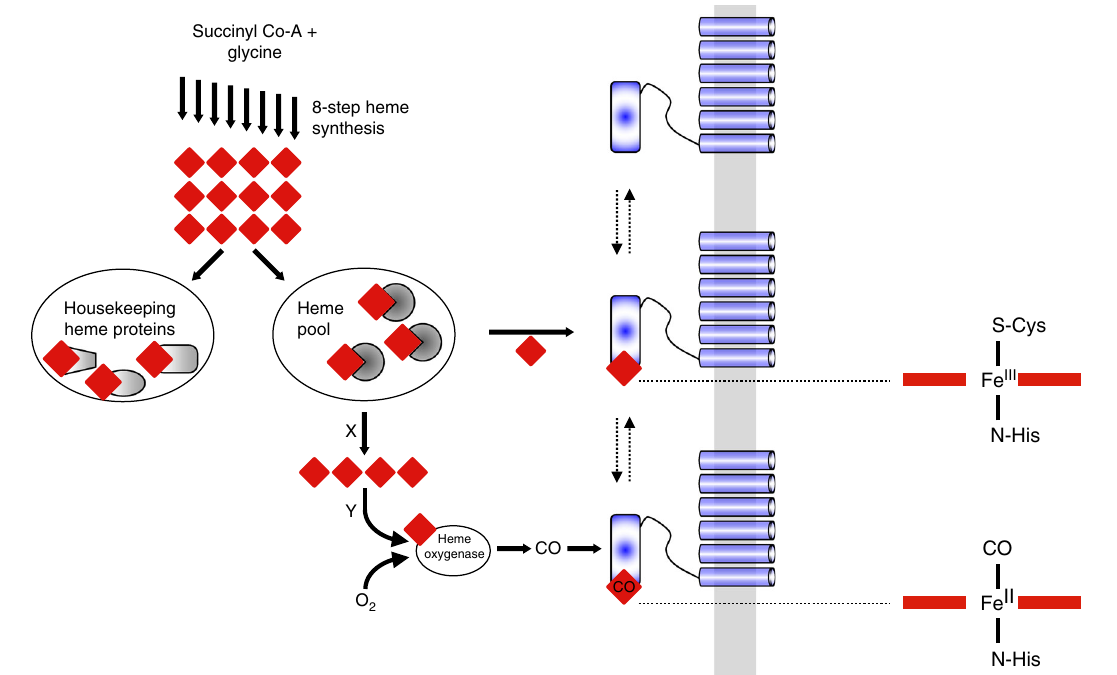
Fig. 4 A molecular basis for CO-dependent activation of K ATP channels. Figure (left) shows the connections that might exist between heme (red diamond) and CO. The 8-step biosynthesis of heme regulates the overall supply. Of the total heme concentration, some is committed to the heme proteins essential for the survival of the cell (left oval). The remainder is thought to exist in a ‘ pool ’ (right oval), probably bound to unknown chaperone proteins. Heme in this pool is available for regulatory control, including binding to ion channel proteins (blue) bound at the membrane (grey). Partner proteins (X, Y) are envisaged as important for heme transport and/or for reduction of the heme to the ferrous (Fe II ) state (prior to binding of gaseous ligands). Formation of CO from the catalytic degradation of heme by the O 2 -dependent heme oxygenase enzyme is envisaged to also interact with heme bound to channel proteins (see text for details). On the far right is shown the proposed ligation in the heme-SUR2A 615 – 933 and heme-CO-SUR2A 615 – 933 complexes. The Cys/His ligation may be retained in the ferrous form, but Fe II -thiolate bonds are weak and replacement by a second (protein) ligand is also possible 37, 56 . Note that the activating effects of CO on the channel are not observed in the absence of heme or when the heme binding site on SUR2A is